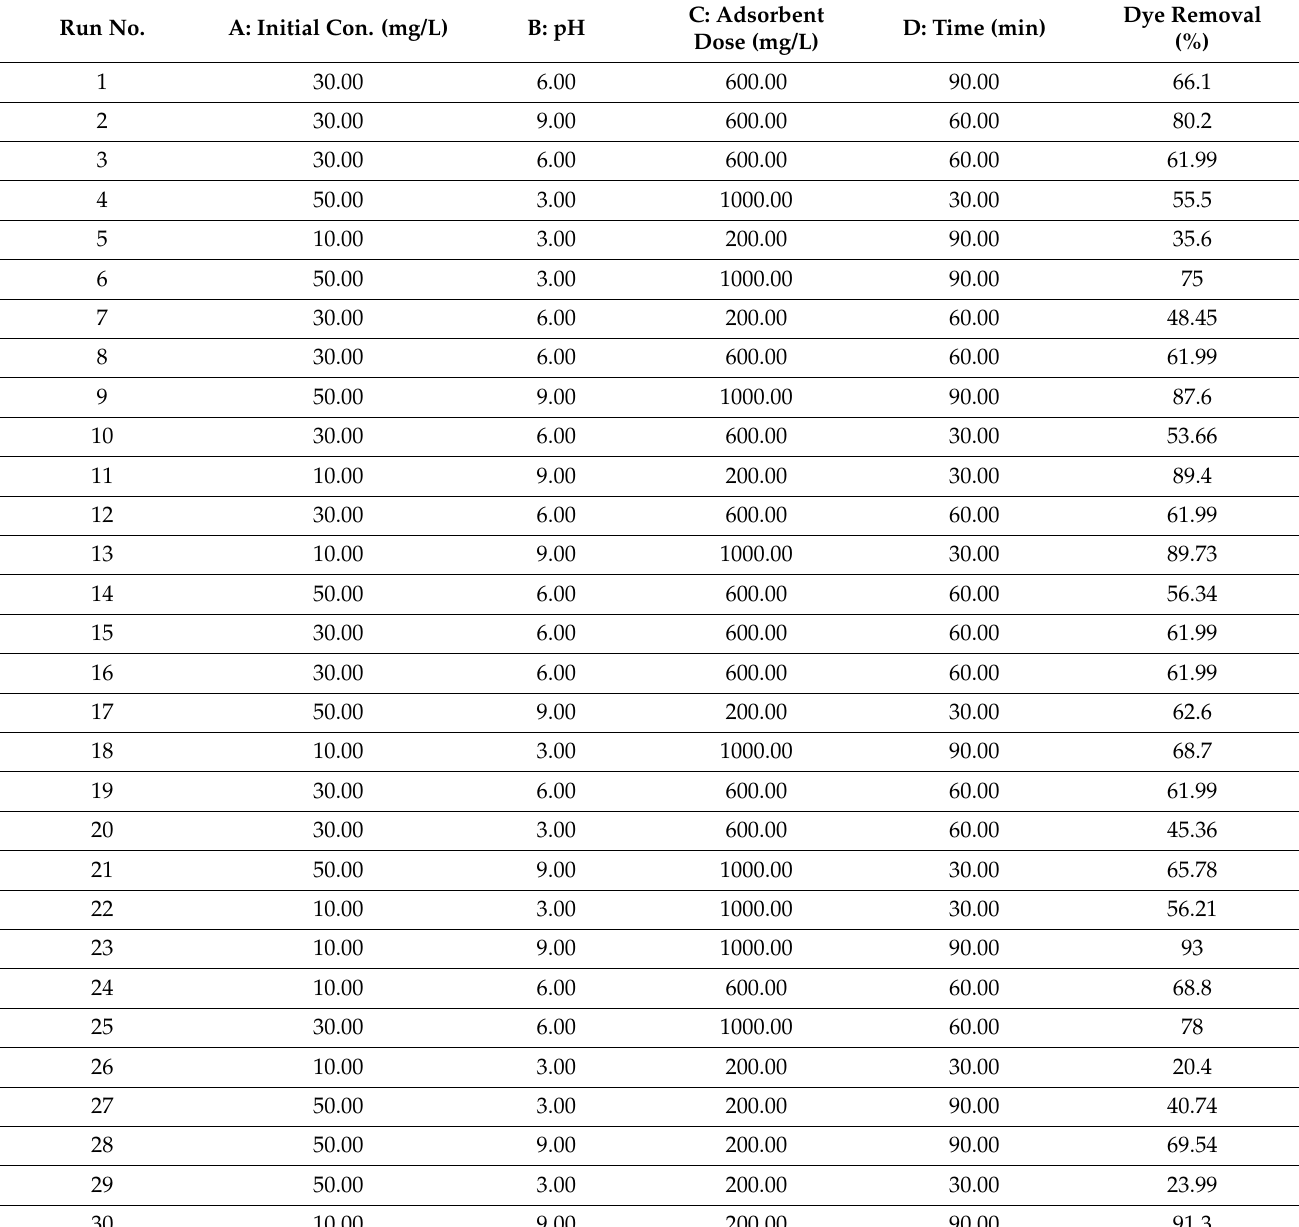
Table 2. Experimental design data in relation to perecentage dye